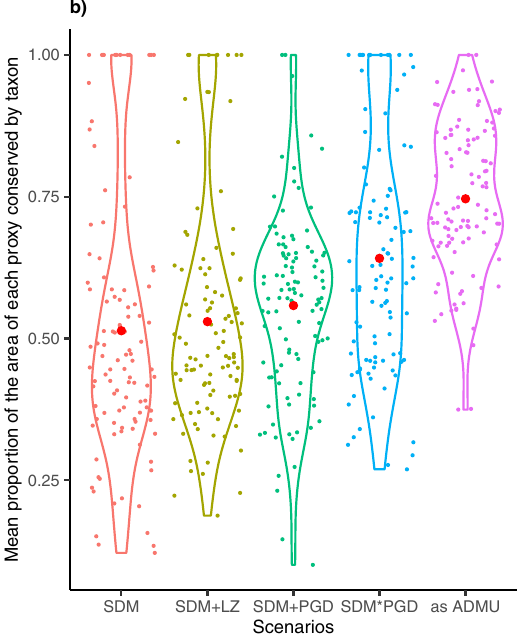
Fig. 4 | Performance of fi ve systematic conservation planning scenarios to represent conservation features of Mesoamerican crop wild relatives, con- sidering 20% of Mexico ’ s terrestrial area. ( a ) Representation curves of the pro- portion of taxa distributions and mean proportion of proxies of genetic differentiation (PGD) areas within them. Smoothing method was locally estimated scatterplot smoothing. Con fi dence intervals (0.95 con fi dence level) around the fi tted line are shown. ( b ) violin plots showing the mean proportion of the area of each proxy represented within each taxon (red dots correspond to the median, colored points correspond to each taxon). Scenarios: (i) SDM, considered 116 taxa with potential species distribution models; (ii) SDM+LZ, considered 116 taxa with potentialdistributionmodelsand27lifezones;(iii)SDM+PGD,considered116taxa